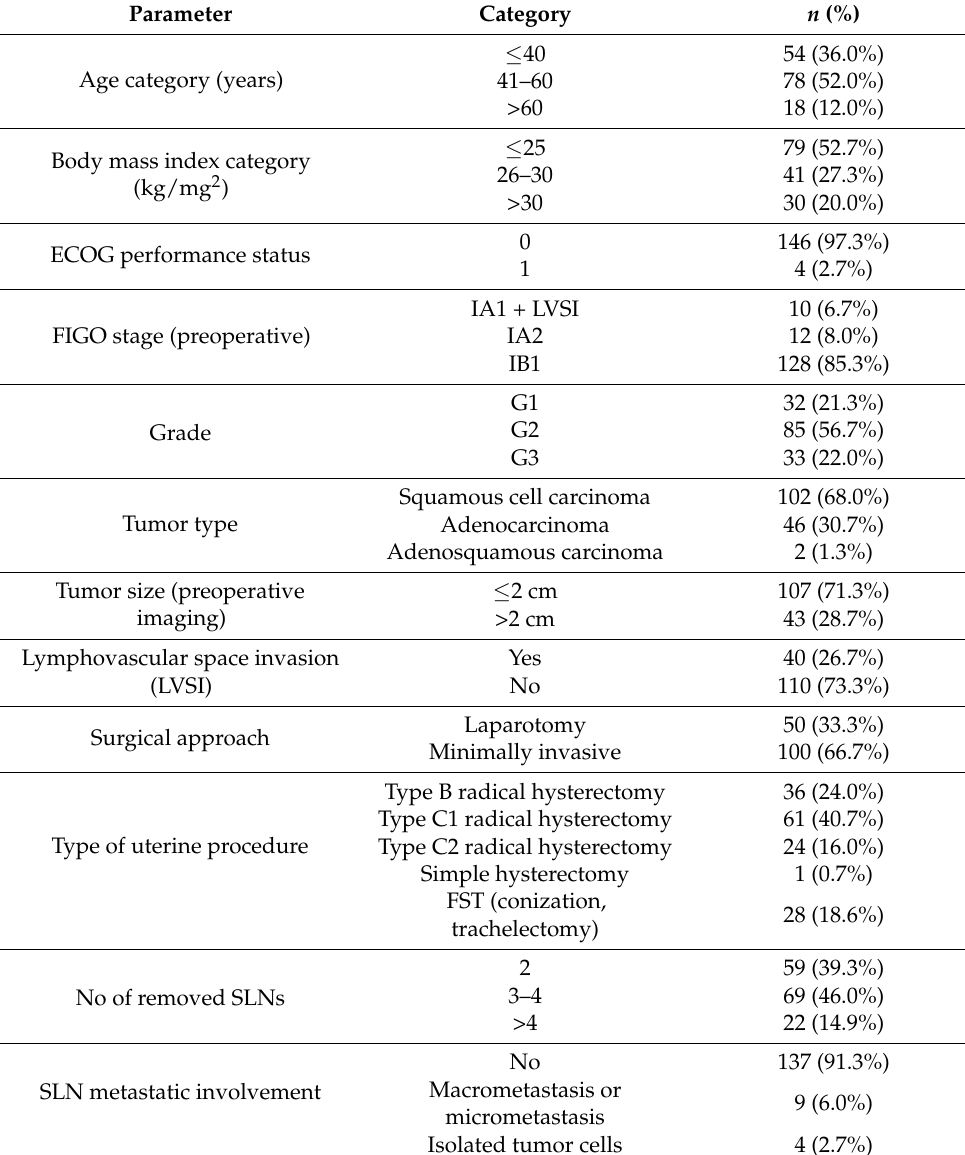
Table 1. Characteristics of patients ( n =